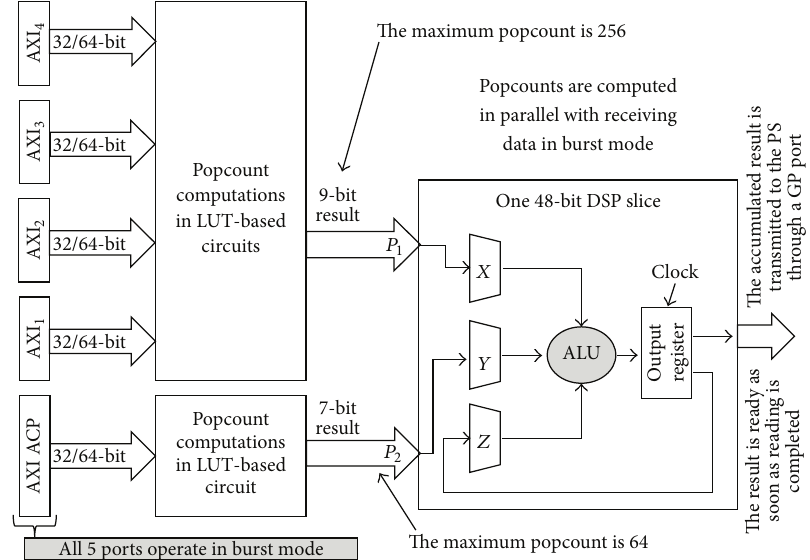
Figure 8: Popcount computations for using 5 AXI ports in burst mode.